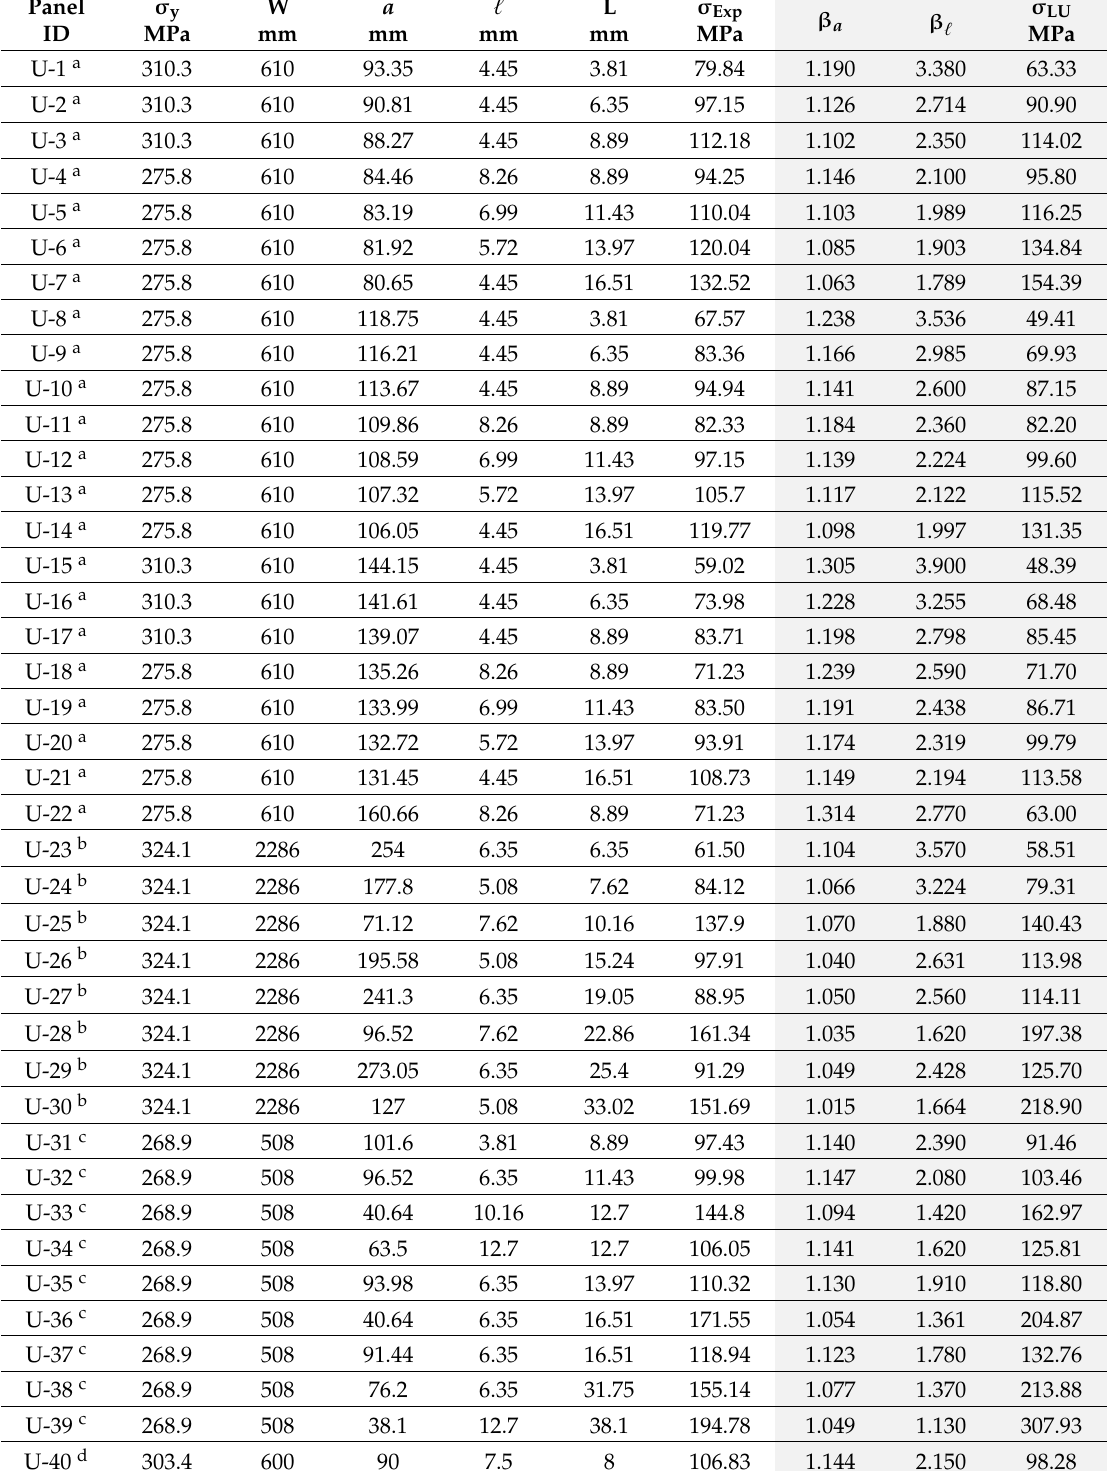
Table A1. Datasets for the unsti ff ened 2024-T3 panels (experimental data and calculated assistance parameters)